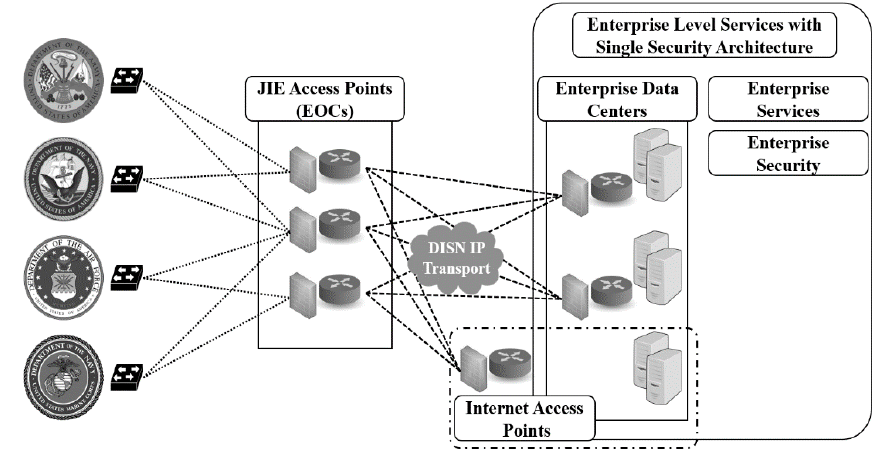
Figure 1. Joint information environment (JIE) Single Security Architecture (SSA) [2].